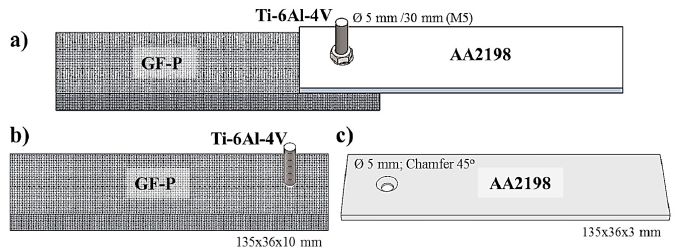
Figure 6. ( a ) Geometry (schematic representation) of a single overlap specimen for lap shear testing; ( b ) Ti-6Al-4V/GF-P friction-riveted joint and ( c ) gusset plate of AA2198.